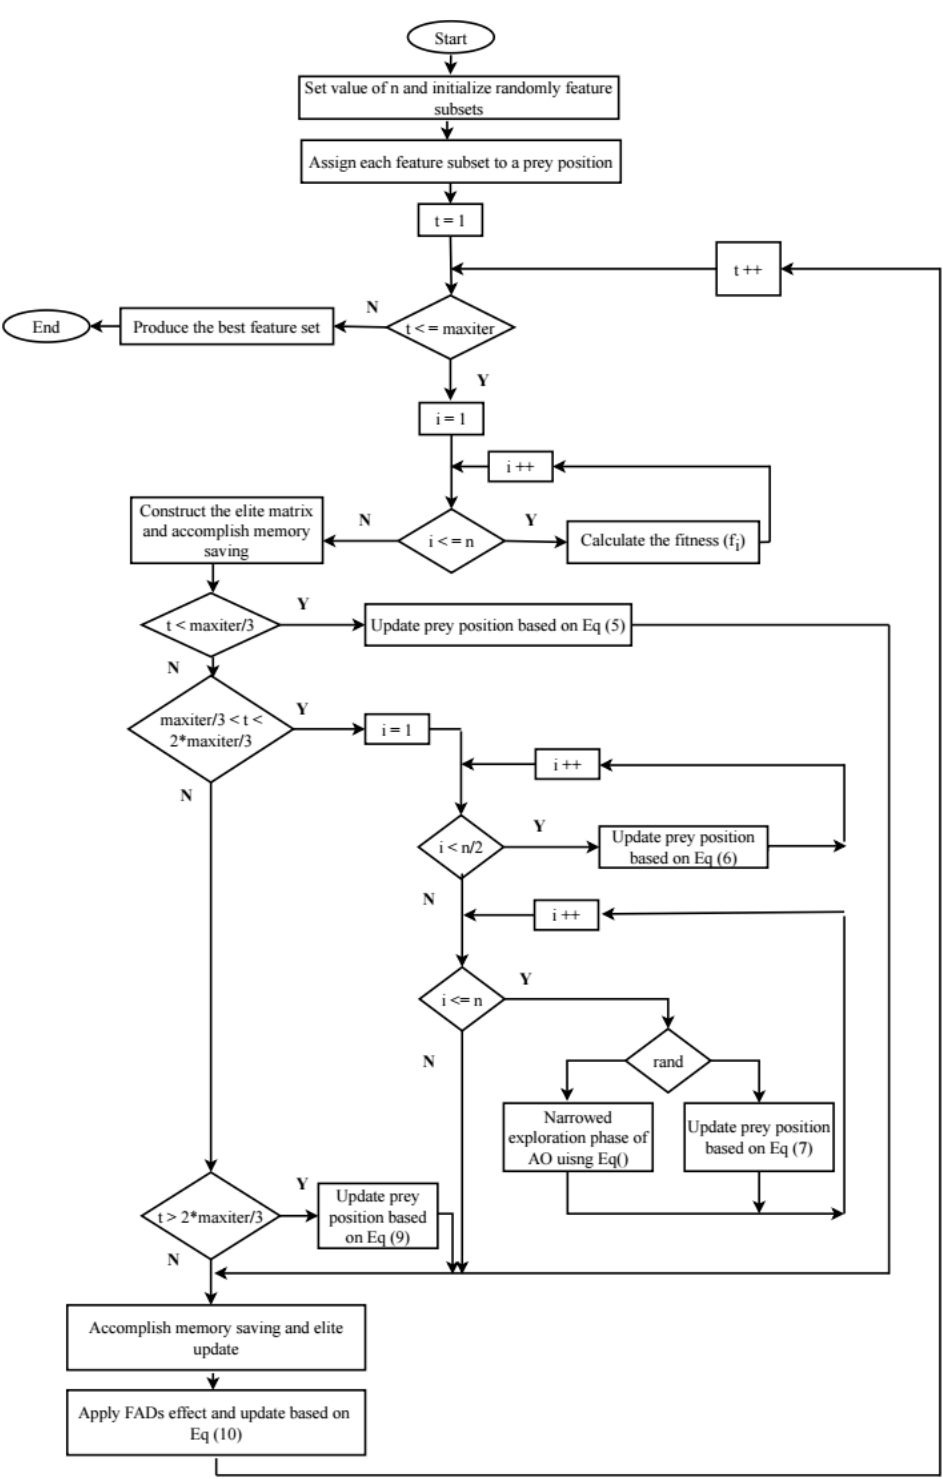
Figure 1. Proposed MPAO